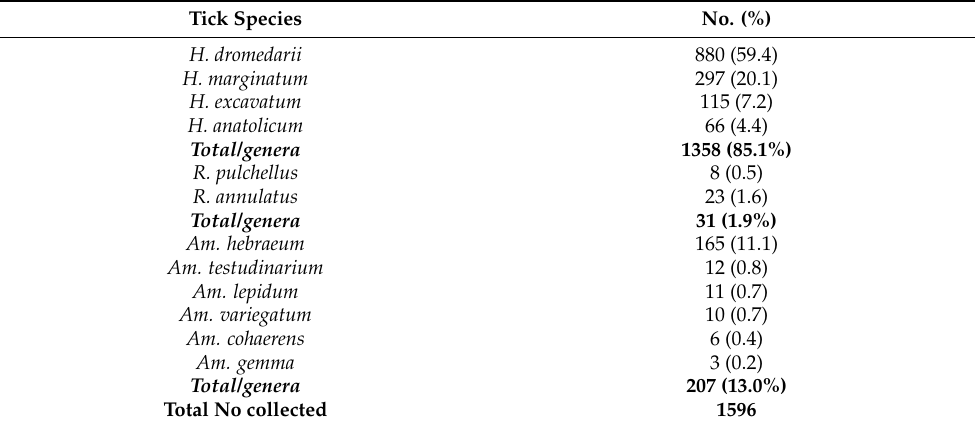
Table 2. Tick species collected from dromedary camels in Cairo and Giza slaughterhouses of Egypt. Tick